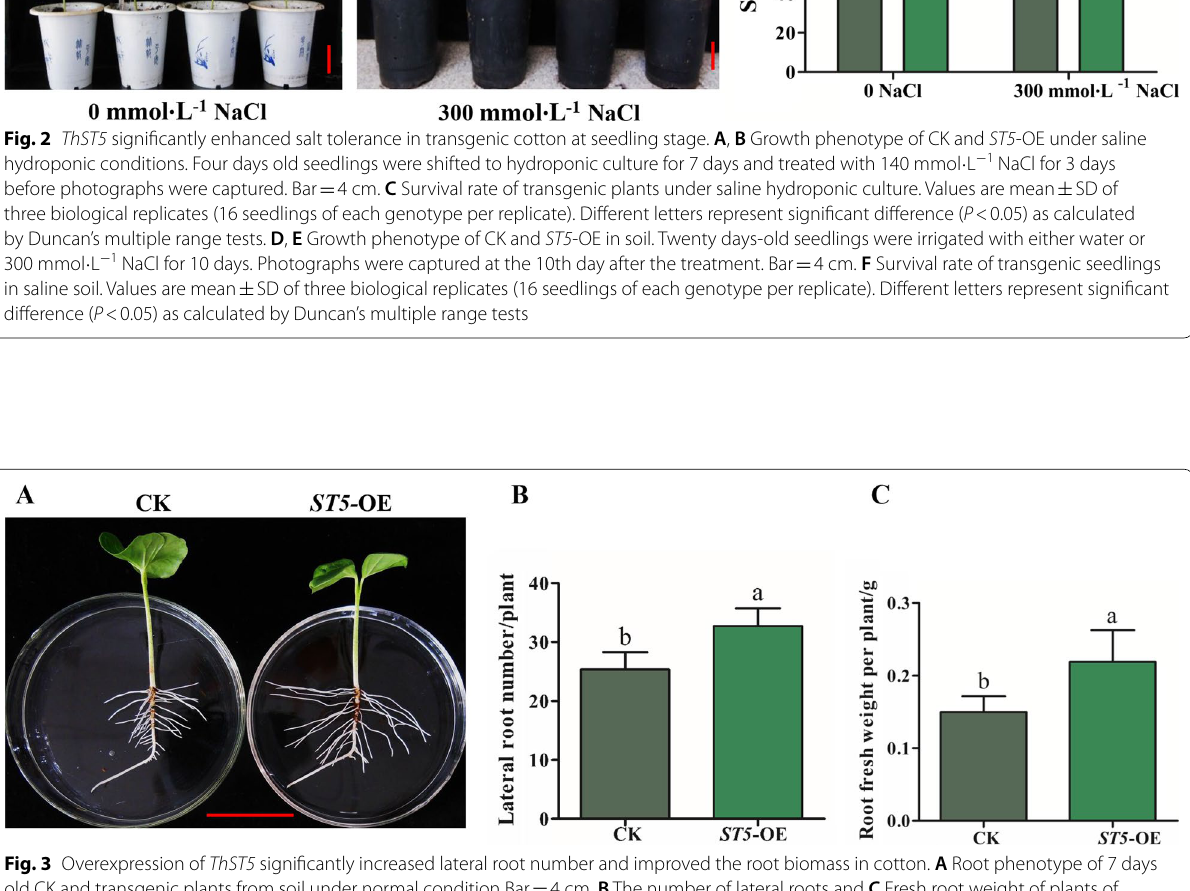
Fig. 3 Overexpression of ThST5 significantly increased lateral root number and improved the root biomass in cotton. A Root phenotype of 7 days old CK and transgenic plants from soil under normal condition Bar 4 cm. B The number of lateral roots and C Fresh root weight of plants of = 7 days after sowing. Values are mean SD of three biological replicates (16 plants of each line/replicate). Different letters represent significant ± difference ( P < 0.05) as calculated by Duncan’s multiple range